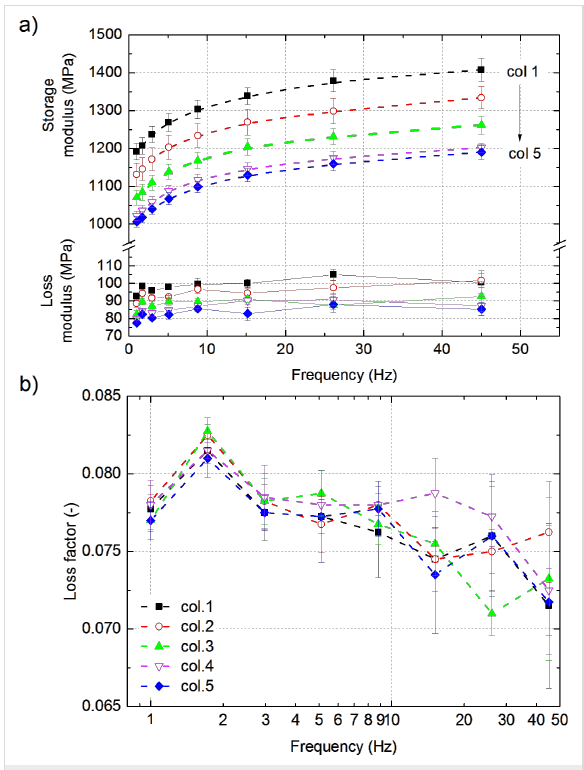
Figure 5: Storage and loss moduli (a) and loss factor (b) measured on the 5 × 4 arrays with flat-punch indentation. An oscillation amplitude of 50 nm and a precompression of 3 μ m were applied. The measure- ments were taken at eight different frequencies in the range from 1 to 45 Hz. Each data point represents the mean for one column per fre- quency. The storage modulus decreases with column number, reaching 41% of the value for untreated PMMA. The loss factor shows no trend regarding the effect of microstructural parameters.